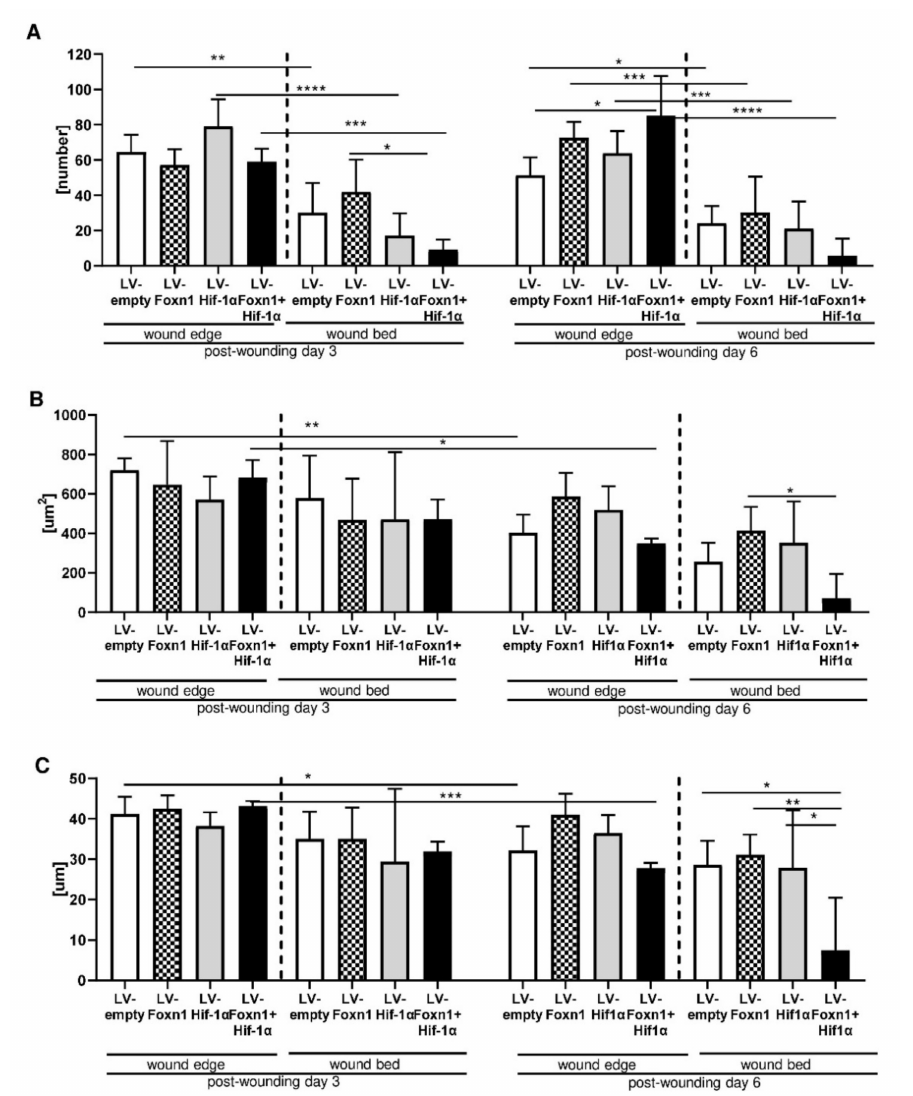
Figure 5. Quantitative analysis of adipocytes: number ( A ), size ( B ) and diameter ( C ) based on perilipin 1-stained skin sections (see Figure 5A) from LV-empty, LV-Hif-1 α , LV-Foxn1- or LV-Hif- 1 α +LV-Foxn1-injected mice. Values are the mean ± SD. Asterisks indicate significant differences (* p < 0.05; ** p < 0.01; *** p < 0.001; **** p <